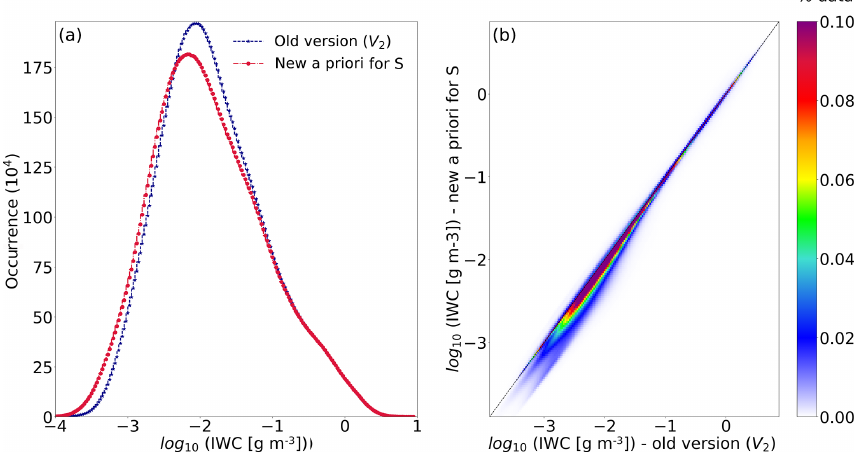
Figure 7. Comparison of the retrieved IWC for two a priori parameterizations of the lidar ratio: panel (a) shows the histograms of log 10 ( IWC ) using the old ( V 2 ) a priori relationship (dashed) and the new ( V 3 ) relationship (solid). Panel (b) shows the probability density distribution of each IWC retrieval relative to the other.